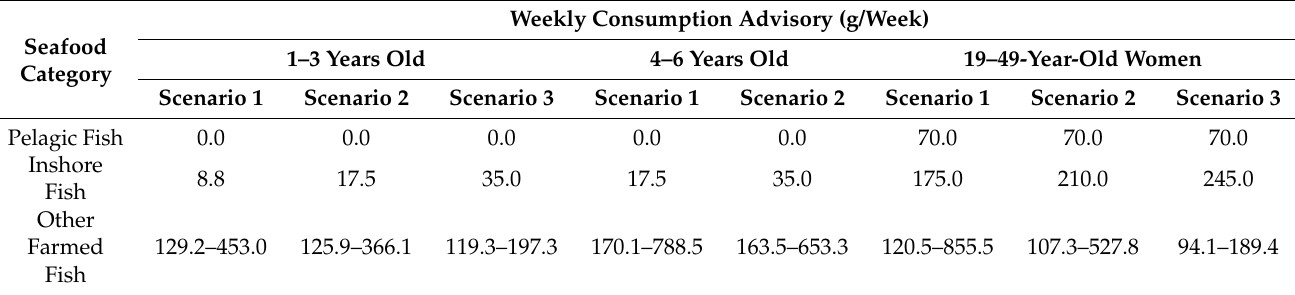
Table 5. Consumption advisories for fish intake